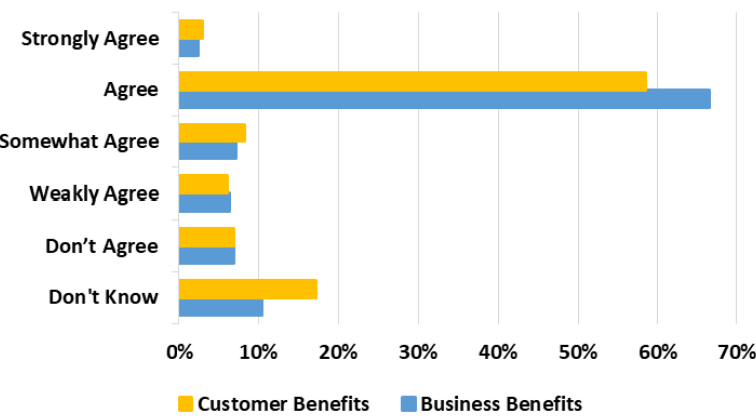
Figure 1. Within each beneficiary group (colour), the Percentage response (x-axis) for each agreement level (y-axis) aggregated across all benefits.